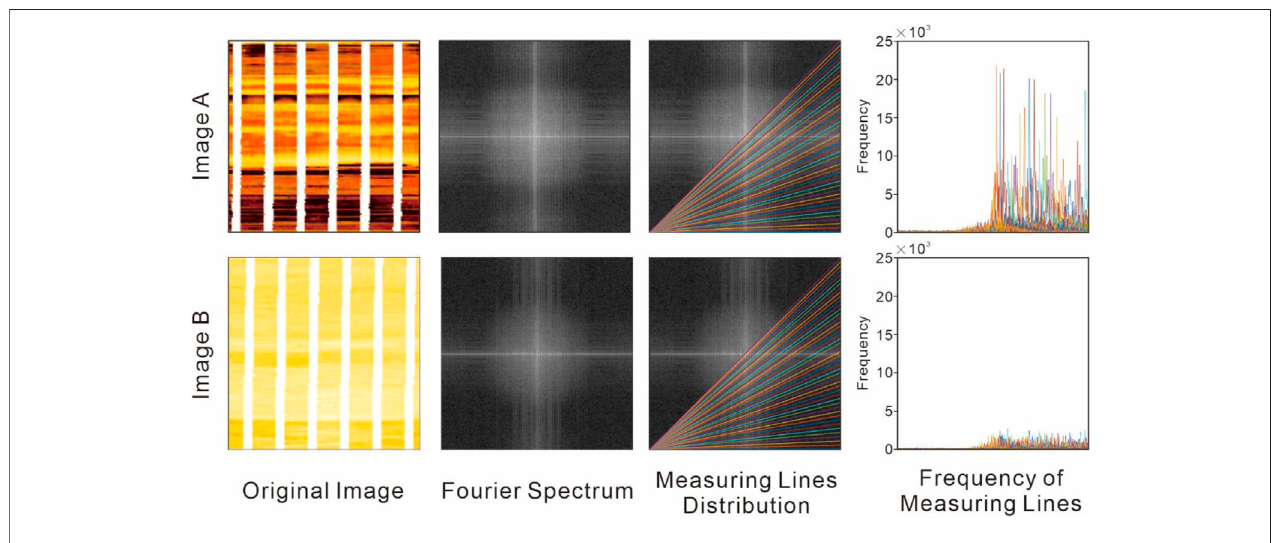
FIGURE 6 | Frequency analysis of different types of imaging